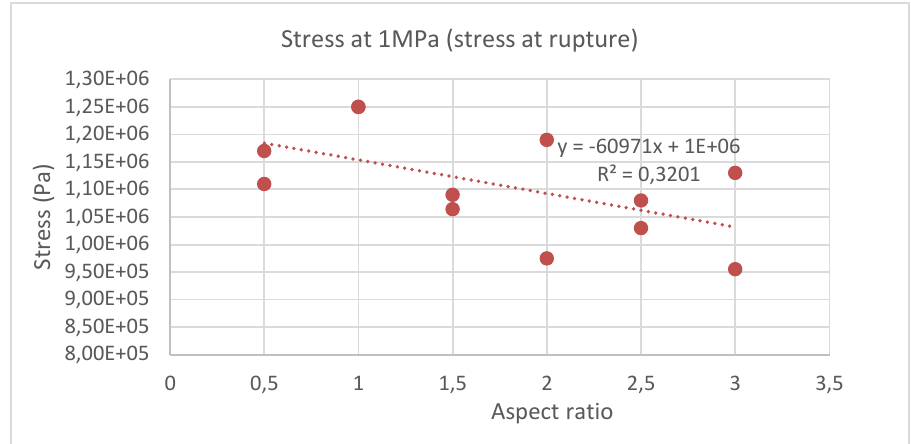
Fig. 2: Stress (MPa) versus Aspect ratio for the different H-pieces